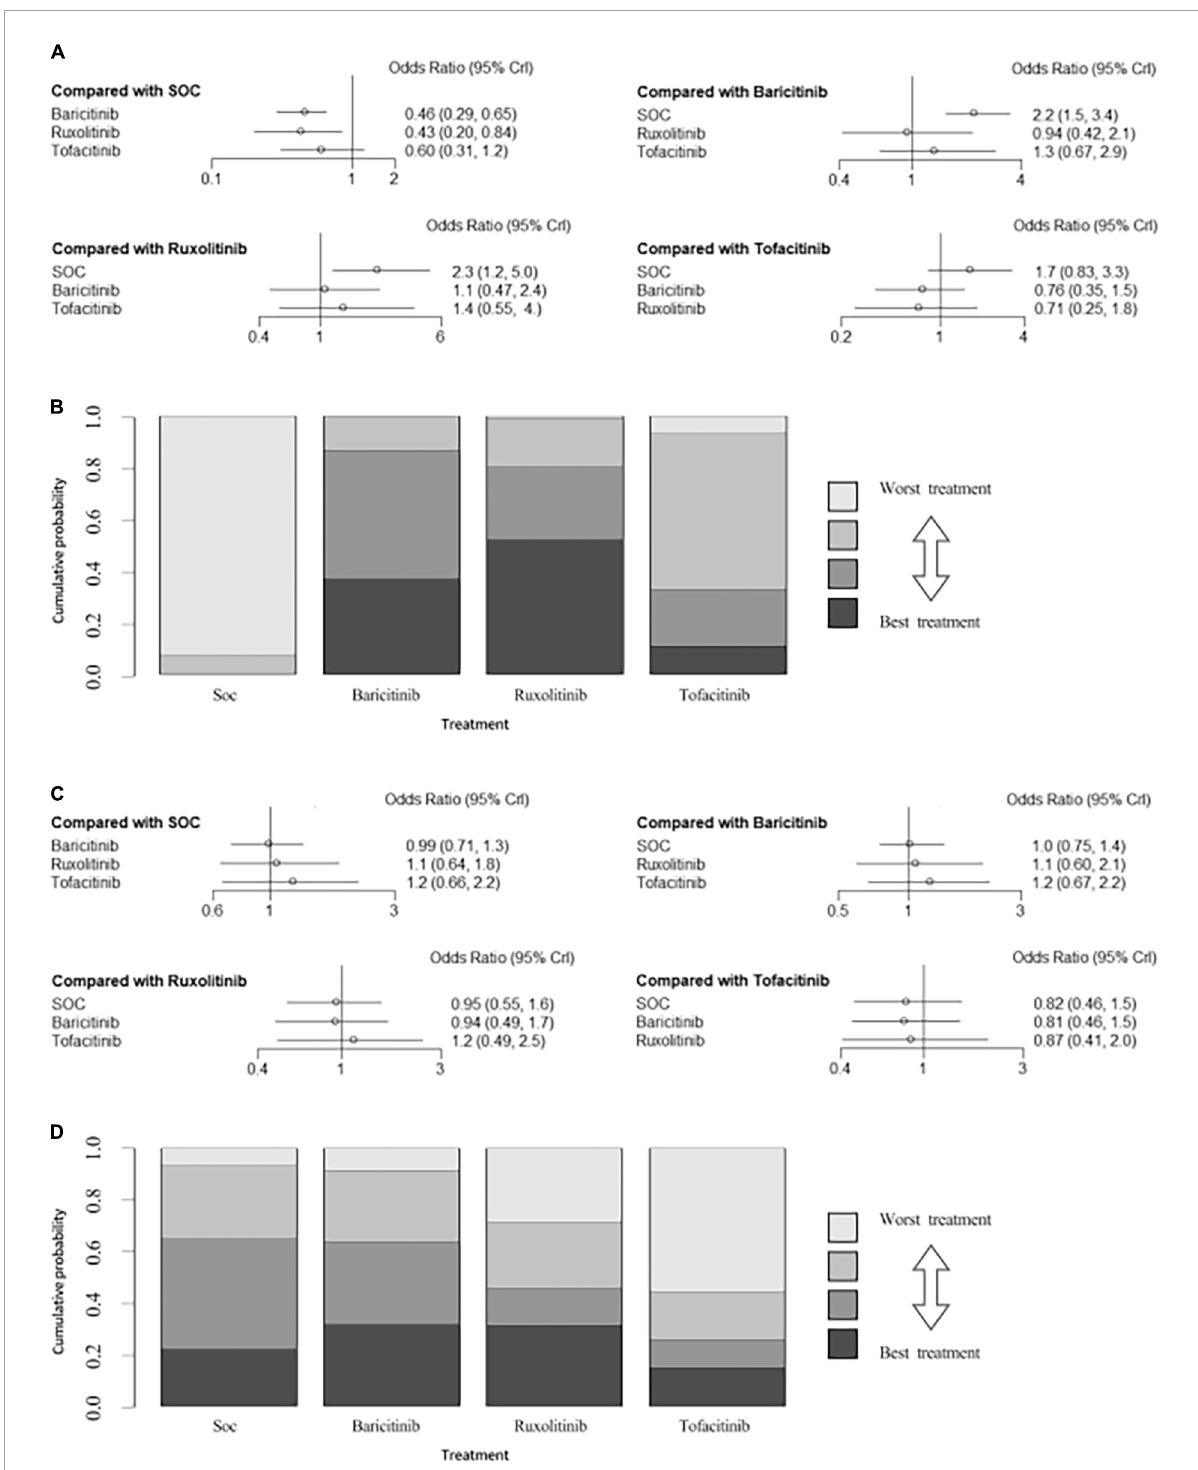
FIGURE6 (A) Network estimates mortality among JAK inhibitors. (B) Rank probabilities among JAK inhibitors for mortality based on the network meta-analysis. (C) Network estimates adverse events among JAK inhibitors. (D) Rank probabilities among JAK inhibitors for adverse events based on the network meta-analysis. CI, confidence